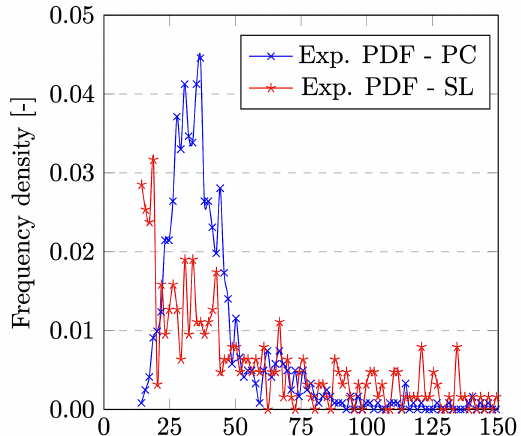
Figure 4. Probability distribution graph of modulus of elasticity of the PC and SL